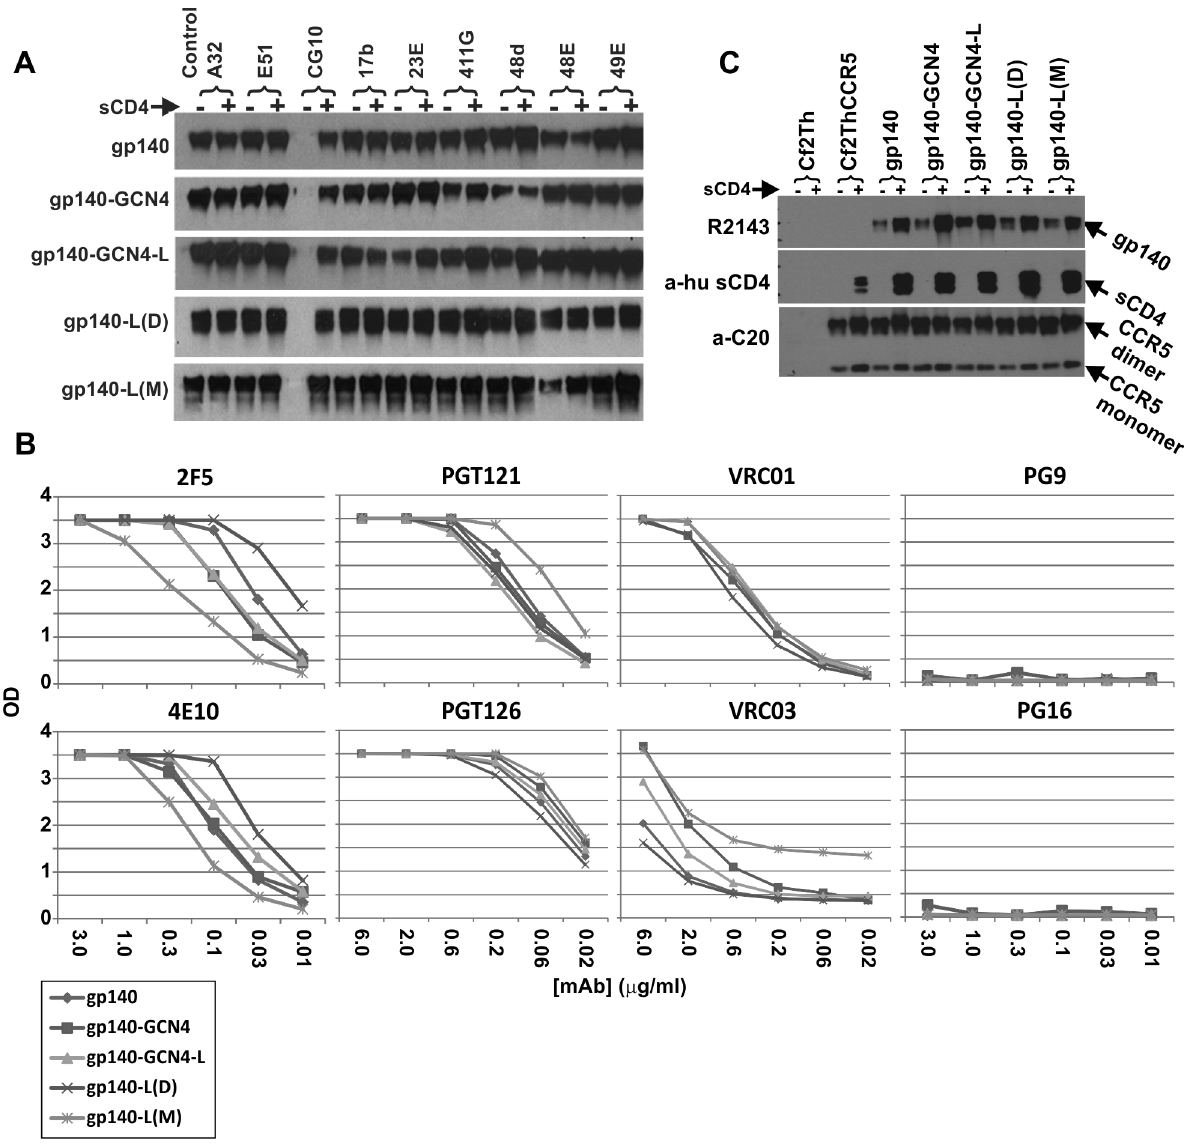
Figure 2. Antigenic reactivity and function of different forms of gp140. (A) Reactivity to CD4i and CD4-gp140 complex specific mAbs (left panel) and monoclonal antibody binding analysis (right panel) of purified R2 gp140(dimer), R2 gp140-GCN4 (trimer), R2 gp140-GCN4-L (trimer), R2gp140-L (dimer), and R2gp140-L (monomer). For the left panel, 1 m g of each of the different versions of purified R2 gp140 was incubated with or without excess (3 m g) sCD4 in 700 m l of reaction buffer (PBS containing 0.5% Triton X-100) at 4 u C for overnight, followed by 2 m g of the indicated mAb for an additional 4 h. All mAbs bound all forms of the gp140 with or without sCD4, except mAb CG10, which probably binds a complex epitope formed by gp120 and CD4 residues. No significant enhancing effect of binding by sCD4 was noted. For the right panel, 1 m g of different versions of purified R2 gp140 was incubated with the indicated mAbs in 700 m l of reaction buffer for 4 h at 4 u C. Each complex was then precipitated with 50 m l of Protein G Sepharose (20% solution) for an additional 2 h at 4 u C. The precipitated complexes were washed, resuspended in SDS-PAGE sample buffer, boiled for 5 min and resolved on 4–12% Bis-Tris SDS-PAGE, and subjected to western blotting. The blots were probed with a polyclonal rabbit anti-gp140 antiserum. The mAbs included human mAbs that are known to neutralize HIV-1 cross-reactively, and murine mAbs (names beginning with ‘‘D’’) used to probe for changes in epitope accessibility in the gp41 ectodomain. (B) Antigenic reactivity of different forms of gp140 with additional humAbs with broad neutralizing cross-reactivity was tested by immunoprecipitation and western blot. (C) Binding of co-receptor CCR5 to different versions of purified R2 gp140 was tested in the presence or absence of sCD4. The proteins tested are shown at the top. The canine thymocyte cell line, Cf2Th, served as a negative control, while the CCR5 expressing Cf2ThCCR5 cells were used as the source of coreceptor. After pre-incubation of the purified R2 gp140s with or without sCD4, the lysed Cf2ThCCR5 cells were applied for binding. After Protein G Sepharose precipitation, the proteins were resolved on 4–12% Bis-Tris SDS-PAGE followed by western blotting. The blots were probed for the presence of CCR5, gp140, and CD4 separately using polyclonal rabbit anti-gp140 antiserum, R2143 (upper panel), polyclonal anti-huCD4 affinity purified Goat IgG (middle panel), and polyclonal goat anti-CCR5 CKR5 (C-20) antibody (lower panel).